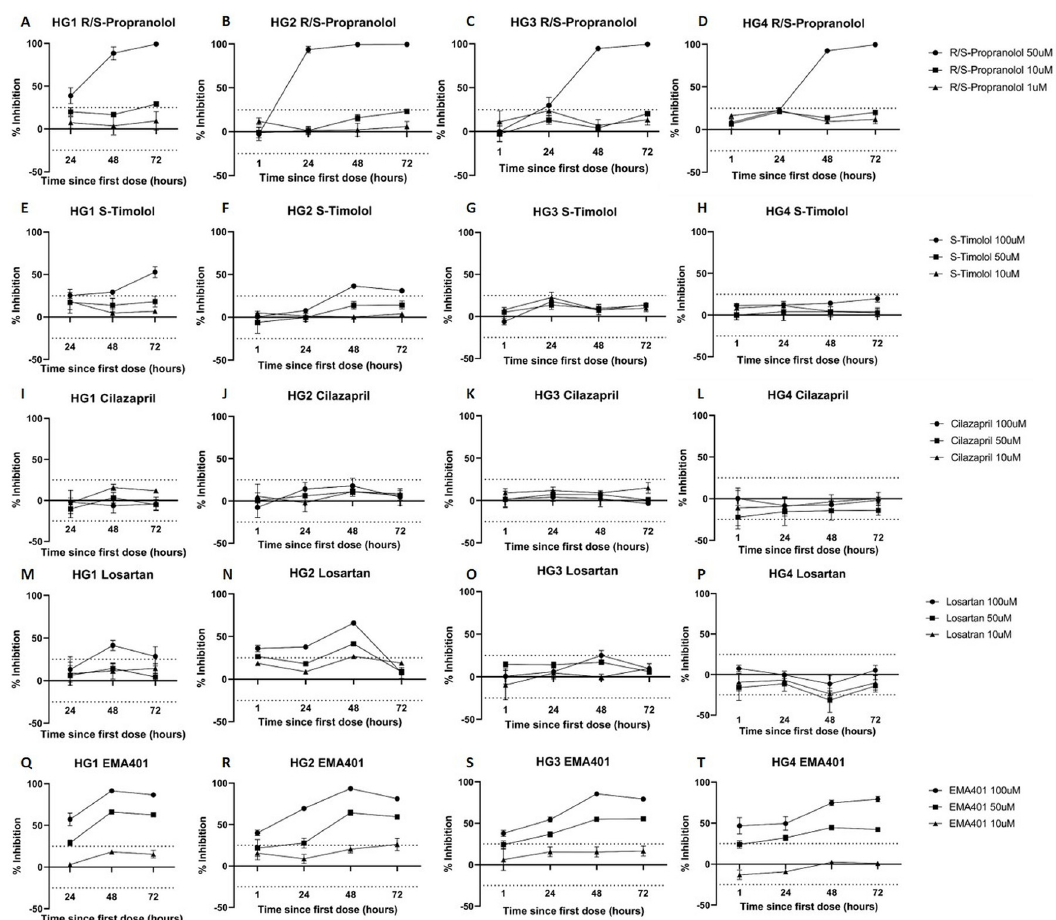
Fig 8. Effect of RASIs on the metabolism of HGCA-derived primary cell lines. Four HGCA-derived cells lines were exposed to racemic propranolol (A-D), S-timolol (E-H), cilazapril (I-L), losartan (M-P) and EMA401 (Q-T) at doses of 50 μ M ( ● ), 10 μ M ( ◼ ) and 1 μ M ( ▲ ). Luminescence produced by cells exposed to RASIs was detected and used to measure the inhibitory effect of treatment on metabolic activity. The y-axis represents the extent of metabolic inhibition in the treated cells relative to the untreated control cells, and because the assay seeks to measure metabolic inhibition, the positive values indicate inhibition and the negative values indicate increased metabolic activity in the drug-treated cells. The x-axis shows the time after initial dose of each luminescence measurement. Each data point is the average of 3 technical replicates, with error bars showing standard deviation. Adapted from [38] under a CC BY license, with permission from Munro MJ et al . 2021.